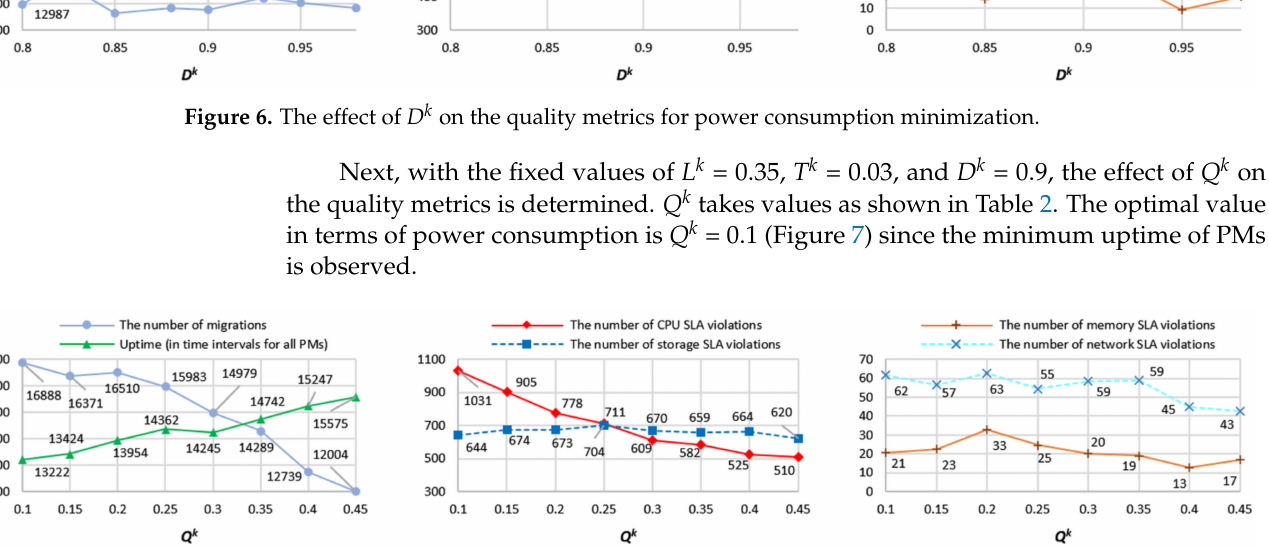
Figure 7. The effect of Q k on the quality metrics for power consumption minimization. Thus, to achieve the minimum power consumption (the minimum uptime of PMs), it is necessary to set the model parameters as follows: L k = 0.35, T k = 0.03, D k = 0.9, and Q k = 0.1. The quality metrics of the power consumption minimization are presented in Figure 8.